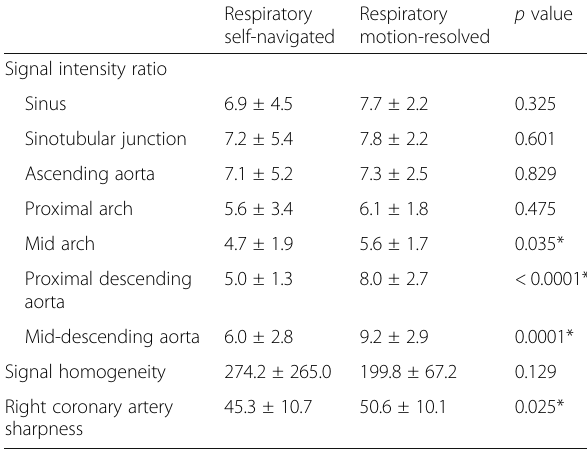
Table 3 Objective image quality